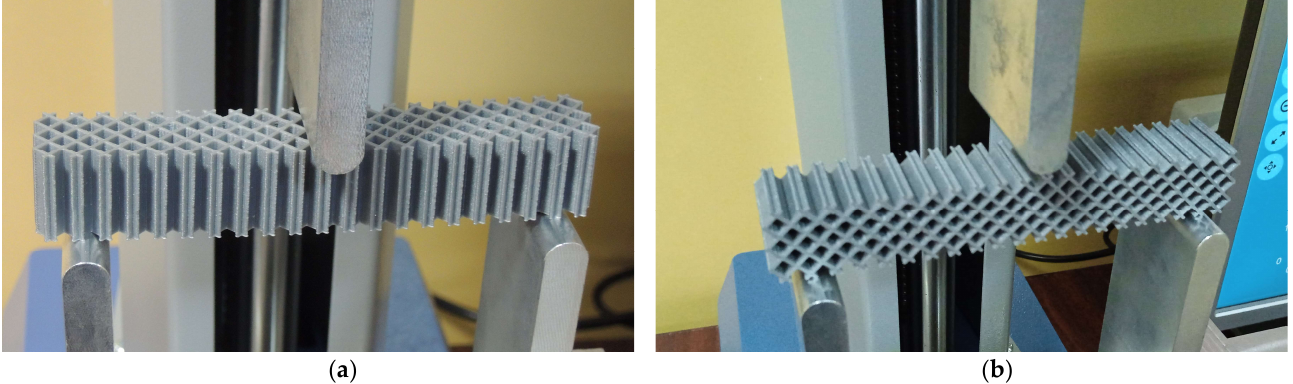
Figure 9. The 3-point bending setup for the grid cells specimen: ( a ) force along the Y-axis of the specimen, ( b ) force along the Z-axis of the specimen.